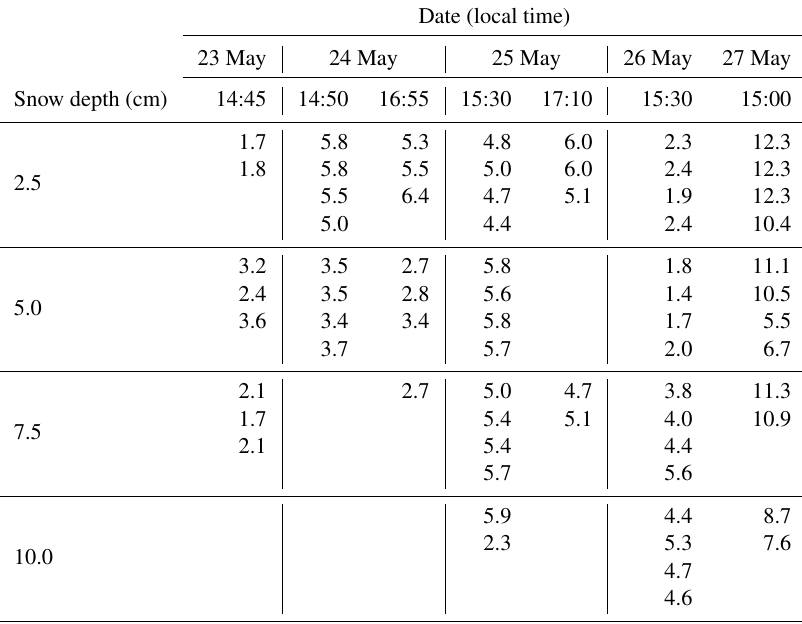
Table 1. Water content of snowpack at different depths observed over ice in the Chukchi Sea north of Utqia˙gvik during 23 May through 27 May 2017. Units: cm 3 water100cm − 3 snow.